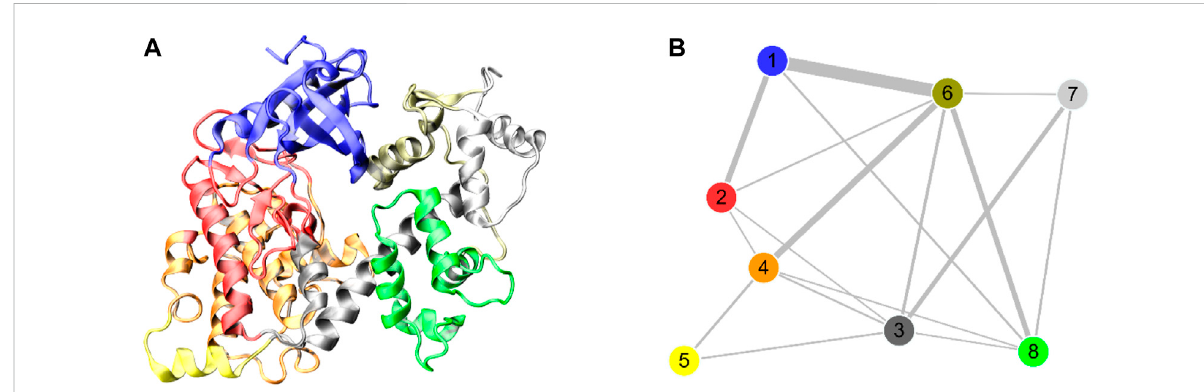
The three-dimensional (A) and two-dimensional (B) visualizations of the difference contact networks for the DAPK1 − CaM complex between the Ca 2+ -bound and-unbound states. The communities are represented by circles with different colors and the widths of sticks connecting communities highlighting the intercommunity connection difference between the two